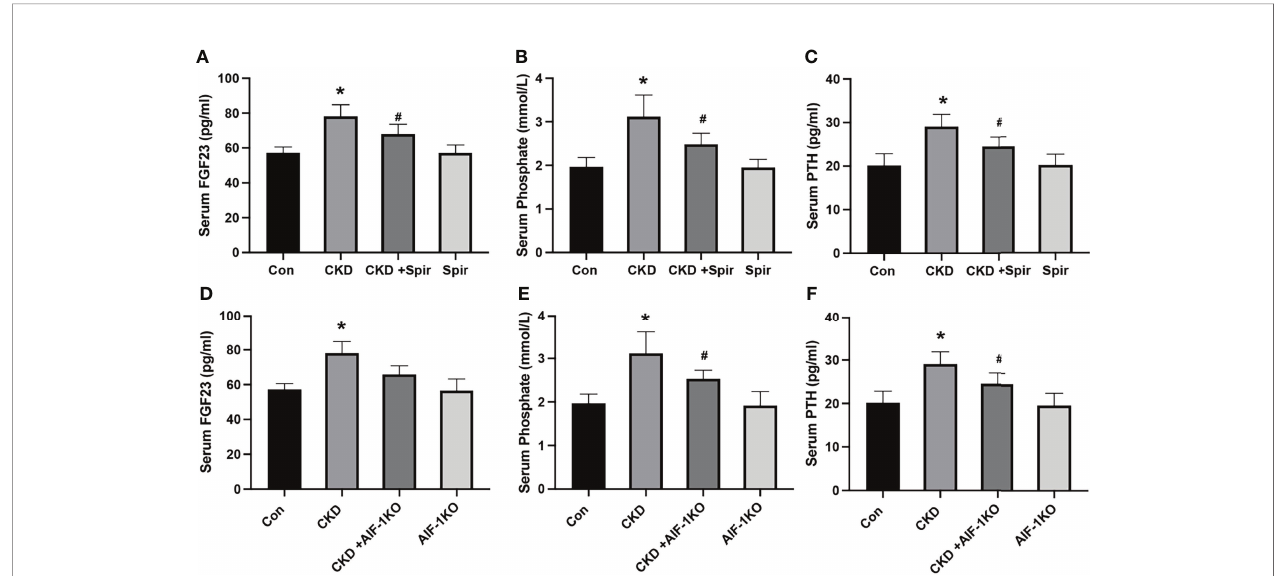
FIGURE 2 | The serum FGF23, Phosphate, and PTH levels in the CKD mice model (A – C) and AIF-1KO mice model (D – F) . (n=6) (*P<0.05, Control group vs. CKD group; # P<0.05, CKD group vs. CKD+Spir group or CKD group vs. AIF-1KO+CKD